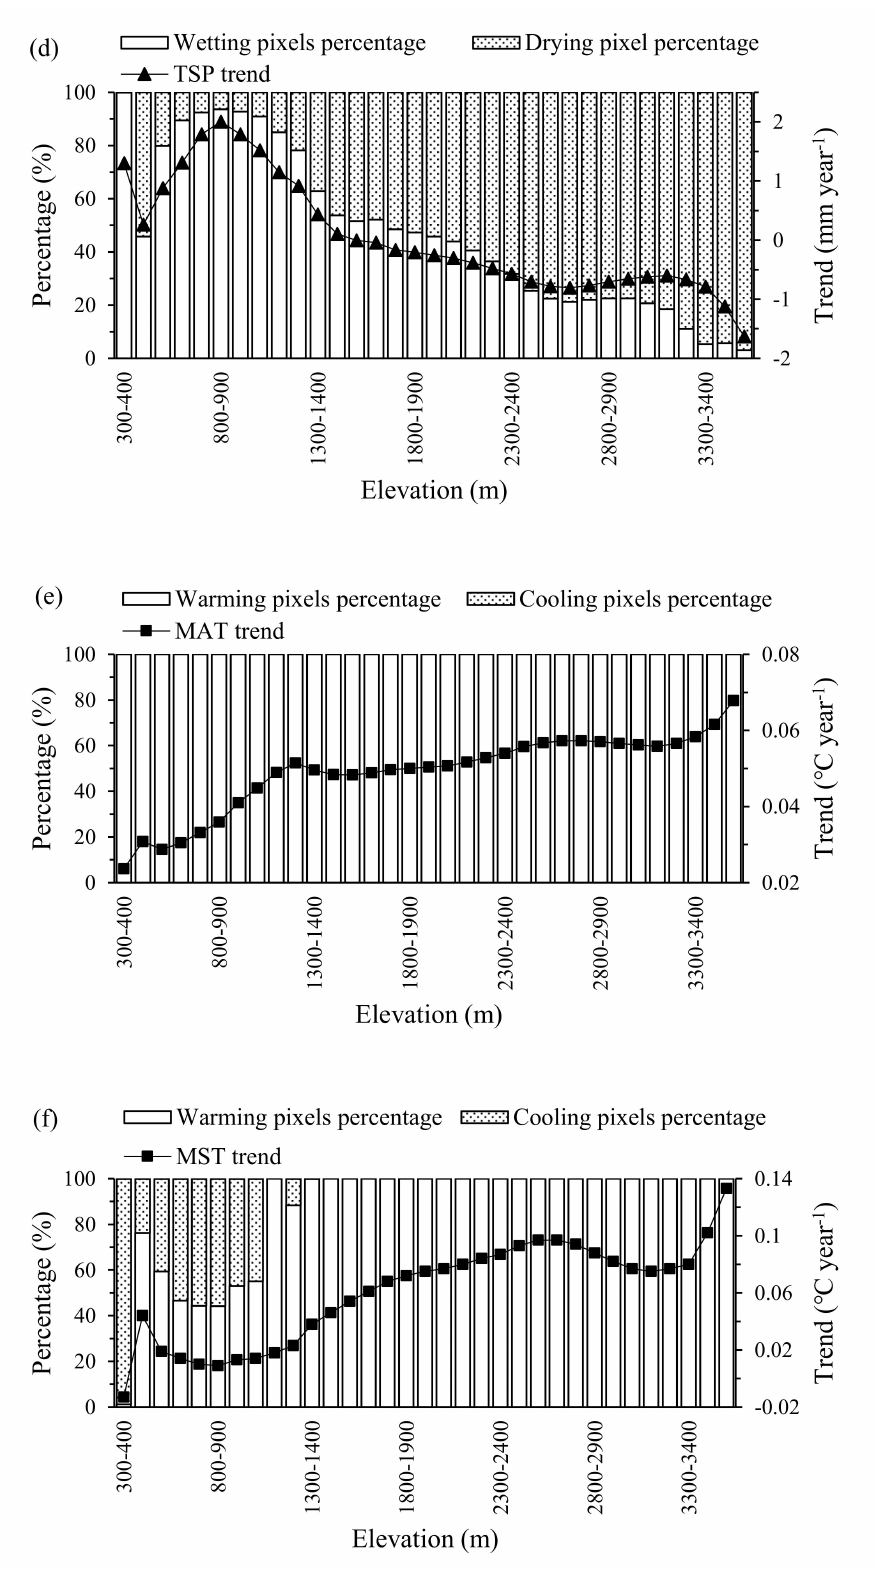
Figure 4. Average annual precipitation and temperature ( a ), average summer precipitation and temperature ( b ), annual precipitation trend ( c ), summer precipitation trend ( d ), annual temperature trend ( e ), and summer temperature trend ( f ) during 2000–2017 for each elevation